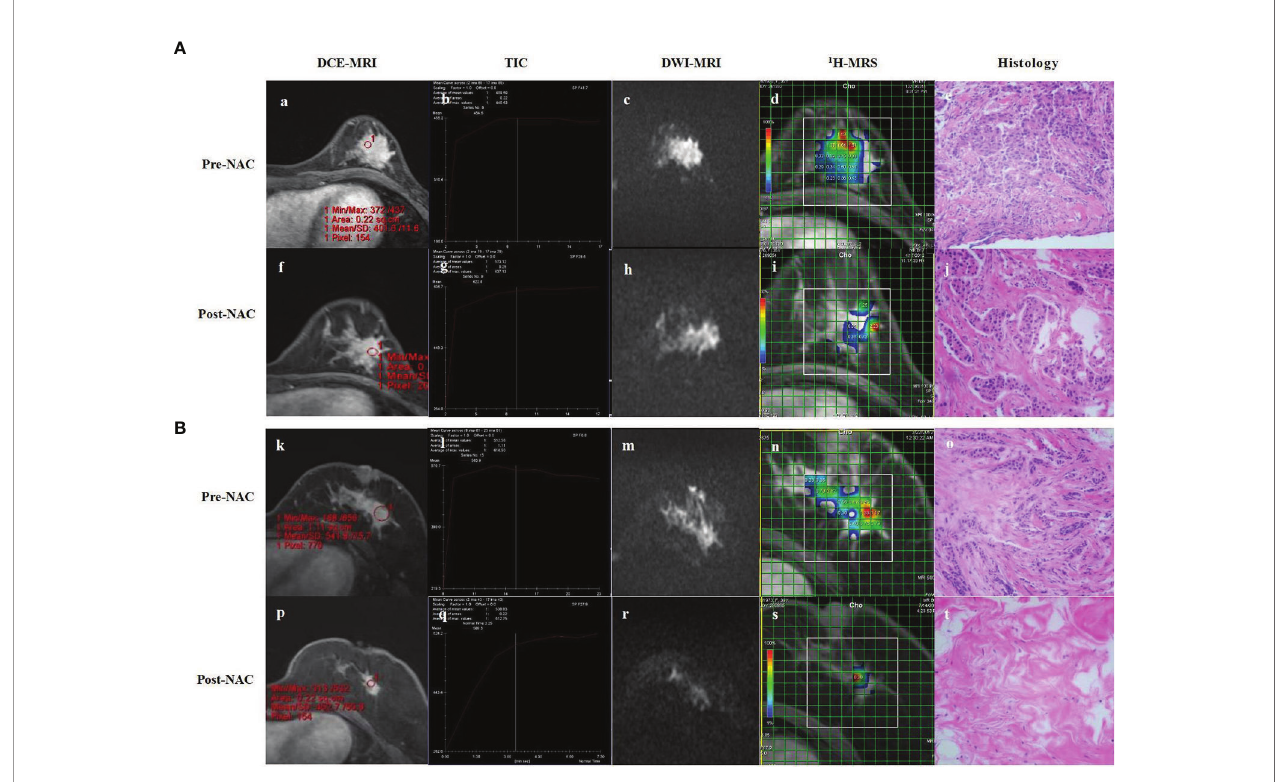
FIGURE 4 | DCE-MRI, TIC, DWI-MRI, 1 H-MRS and histology of partial responder (A) and complete responder (B) before start of NAC (Pre-NAC) and after 8 course of NAC (Post-NAC). (A) (a) DCE-MRI: the tumor was marked enhancement and irregular margins. (b) TIC : Fast In fl ow - Platform Type. (c) DWI-MRI: the ADC value was 0.73 x 10 -3 mm 2 /s. (d) 1 H-MRS: high Cho levels. (e) Microscopic image of core-needle biopsy. After 8 course of NAC. (f) DCE-MRI: the mass shows a concentric shrinkage pattern. It is suggestive of partial response. (g) TIC : Fast In fl ow - Platform Type. (h) DWI-MRI: the ADC value was 0.96 x 10 – 3 mm 2 /s. (i) 1 H-MRS: lower Cho levels compared to baseline. (j) Microscopic image after NAC shows residual tumor cells, but reduced compared to baseline. (B) (k) DCE-MRI: the tumor was marked enhancement and irregular margins. (l) TIC : Fast In fl ow - Platform Type. (m) DCE-MRI: The ADC value was 0.83 x 10 -3 mm 2 /s. (n) 1 H-MRS: high Cho levels. (o) Microscopic image of core-needle biopsy. After 8 course of NAC. (p) DCE-MRI: signi fi cant reduction of the mass compared to baseline. (q) TIC : Rapid In fl ow - In fl ow Type. (r) DCE-MRI: the ADC value was 1.39 x 10 – 3 mm 2 /s. (s) 1 H-MRS: signi fi cant shrinkage of the tumor and a signi fi cant decrease of Cho levels. (t) Microscopic image after NAC shows lymphocyte and stromal tissue, no visible tumor cells. DCE-MRI, dynamic contrast-enhanced MRI; TIC, time-signal intensity curve; DWI-MRI¸ quantitative diffusion-weighted imaging MRI; 1 H-MRS, 1 H-magnetic resonance spectroscopy; NAC, neoadjuvant chemotherapy; ADC, apparent diffusion coef fi cient; Cho,